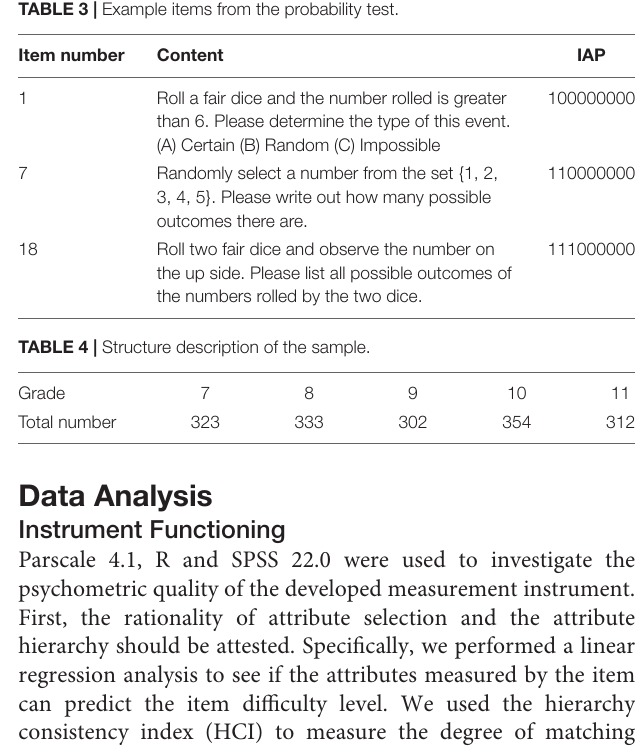
TABLE 3 | Example items from the probability test.